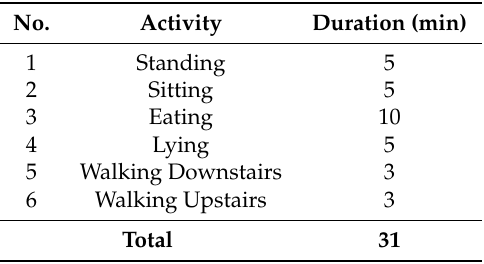
Table 3. Experiment protocol in the controlled environment (one